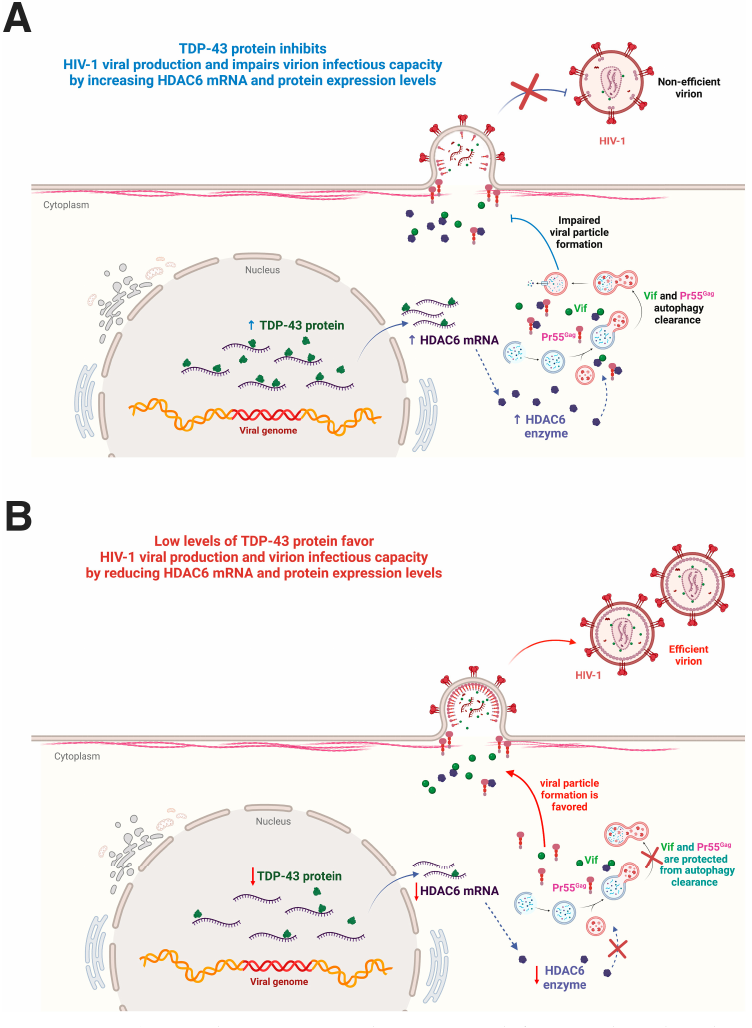
Figure 8. Scheme summarizing the TDP-43 control of HIV-1 viral particle production and virus infectiveness. ( A ) The overexpression of functional TDP-43 leads to an increase of HDAC6 mRNA and protein levels, which promote the autophagic clearance of HIV-1 Pr55 Gag and Vif proteins, thereby inhibiting viral particle production and virus infectivity. These viral particles incorporate a reduced amount of HIV-1 Pr55 Gag and Vif proteins. ( B ) Endogenous TDP-43 silencing reduces HDAC6 expression (i.e., mRNA and protein), stabilizes HIV-1 Vif and Pr55 Gag proteins, and favors their incorporation into virions, thereby promoting HIV-1 viral particle production and infectious capacity. Thus, there is a direct relationship between the content of HIV-1 Vif and Pr55 Gag proteins in virions and their infection capacity. Therefore, TDP-43 (i.e., the TDP-43/HDAC6 axis) could be considered a key factor to control HIV-1 viral production and virus infectiveness. Designs and templates were created with BioRender.